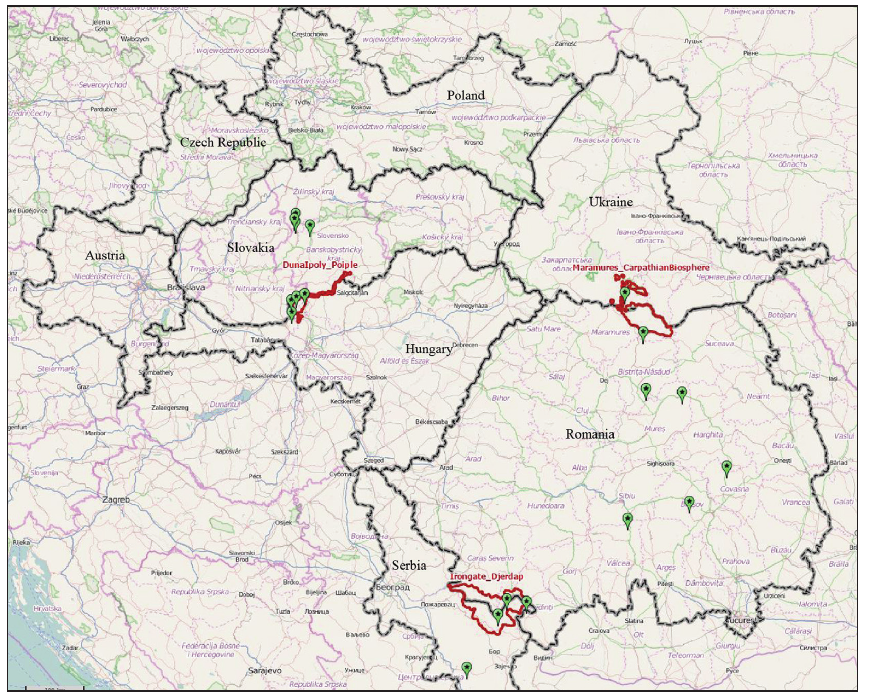
Figure 2. Web-GIS screenshot showing the selected locations (green dots) for the site visit analysis. The red polygons show the Pilot Areas (from http://webgis.eurac.edu/bioregio/).